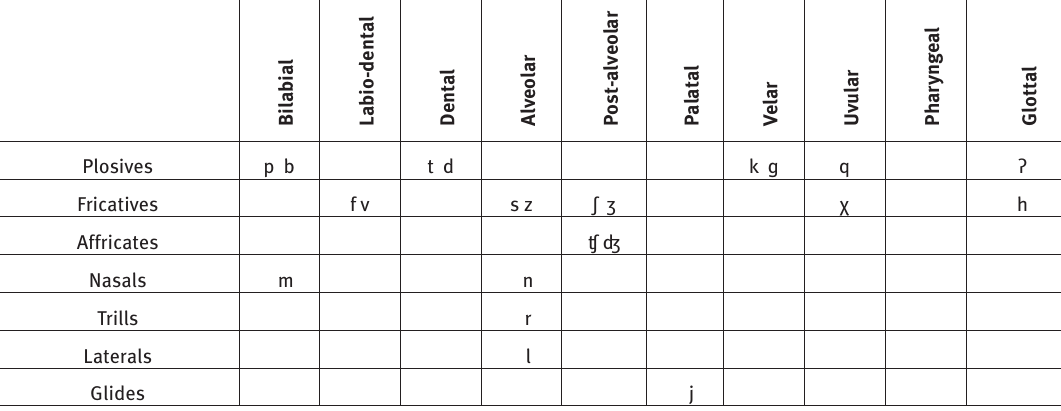
Table 1: Manners and places of articulation of consonants in Sabzevari (Aldaghi and Tavakoli 2011: